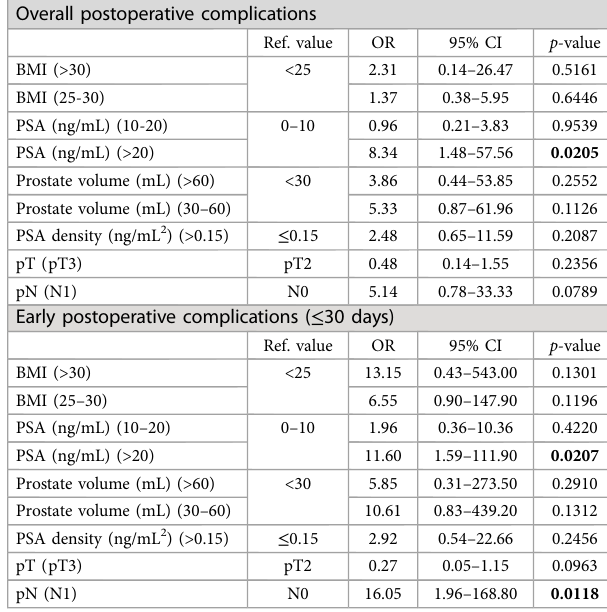
TABLE 2 Multiple logistic regression test. Overall postoperative